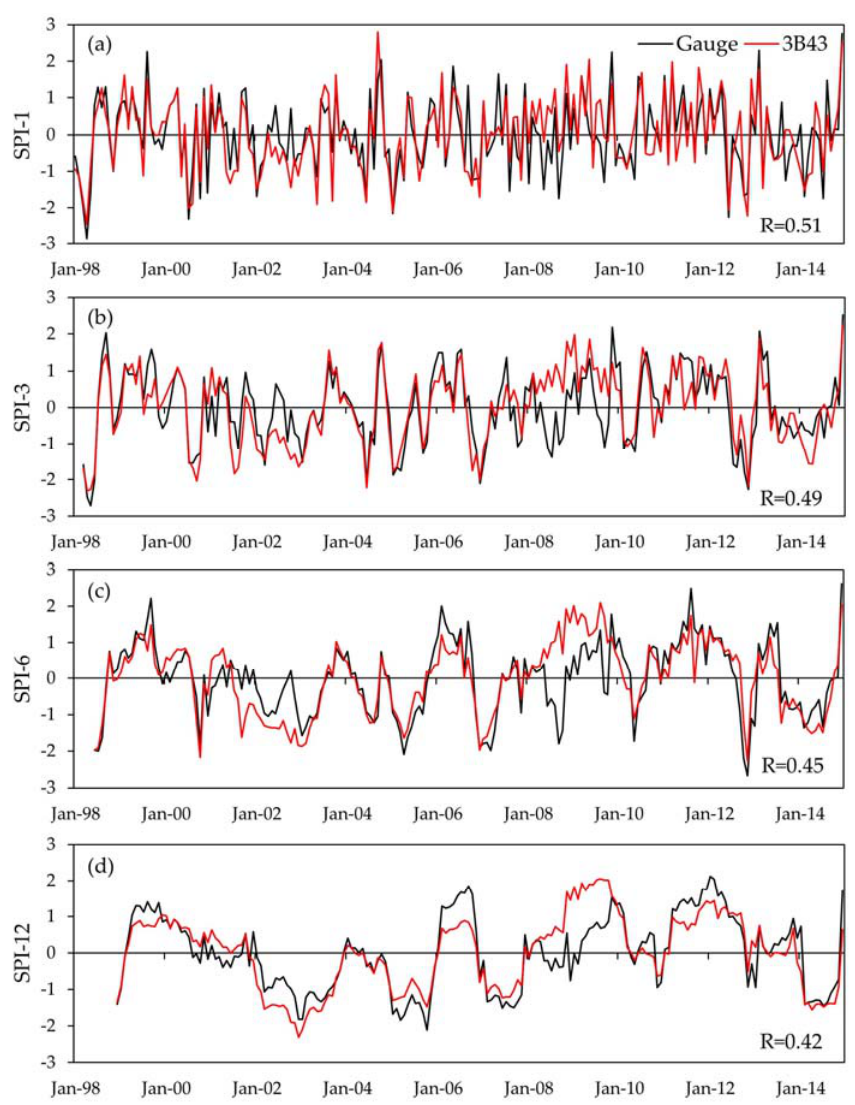
Figure 5. Standardized Precipitation Index (SPI) in the Kelantan River Basin at different time-scales: ( a ) one-month; ( b ) three-month; ( c ) six-month and ( d ) twelve-month from 1998 to 2014.